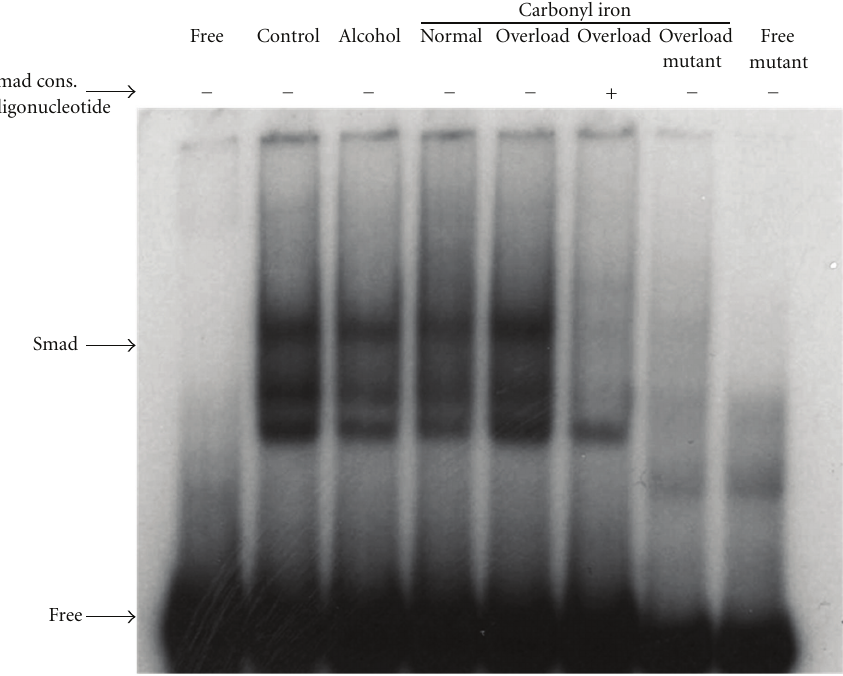
Figure 8: Smad4 DNA-Binding Activity . Smad DNA-binding activity was determined by electrophoretic mobility gelshift assays (EMSA), as described in Materials and Methods. 7 μ g of nuclear lysate protein isolated from the livers of mice fed with regular (control) or ethanol- containing (alcohol) Lieber-De Carli liquid diets, and of mice fed with diets containing 0.2% (normal) or 2% (overload) carbonyl iron was employed in EMSA. Cold competition with unlabeled Smad consensus (cons.) oligonucleotides and 32 P-labeled mutant Smad probe were employed to test the specificity of DNA binding, as described in Materials and Methods. The arrows indicate specific Smad DNA complexes and unbound (free) probes. The results are representative of multiple EMSA experiments ( n =